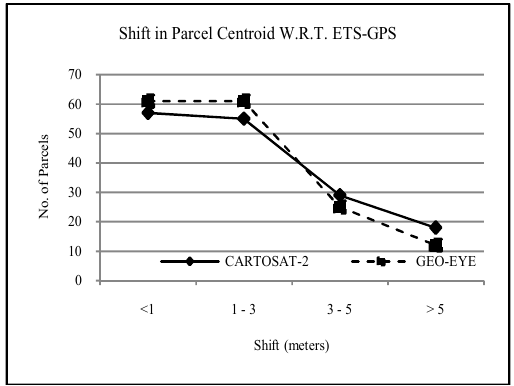
Figure 12. Plot of number of Parcels against the percentage error of position in CARTOSAT-2 and GEO-EYE with respect to ETS-GPS